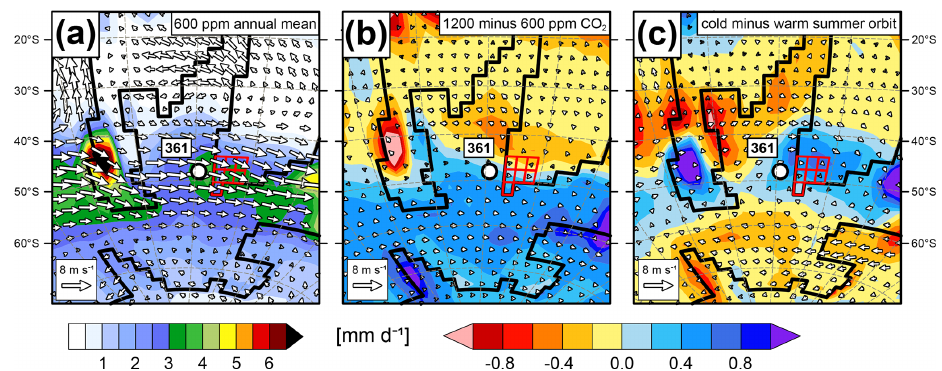
Figure 10. Large-scale atmospheric circulation and climate sensitivity of the study region: (a) simulated annual mean surface wind and precipitation at 600ppm p CO 2 and modern orbital configuration, (b) mean annual wind and precipitation changes due to a doubling of atmospheric p CO 2 (constant orbital configuration), and (c) mean annual wind and precipitation changes related to orbital forcing (i.e., difference between cold and warm summer orbital configuration at 600ppm p CO 2 ). Highlighted grid points show the proposed catchment area. For more details on the modeling data, the reader is referred to Supplement file S4.